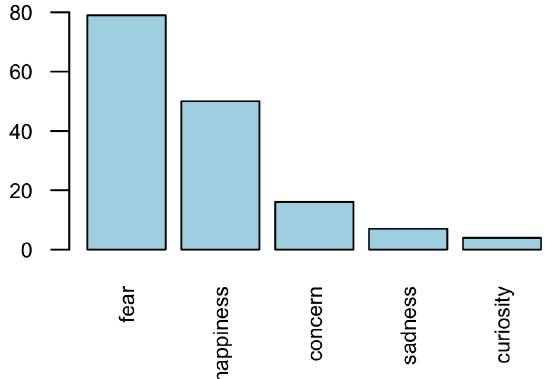
Figure 4. Frequencies of terms related to sentiments like fear, hap- piness, concern, sadness, and curiosity. The corresponding Italian terms are as follows: fear – paura (fear), panico (panic), impaurito (frightened), spaventato (scared), and spaventare (to scare); hap- piness – felice (happy), contento (glad), and gioia (joy); concern – preoccupato (worried) and preoccupazione (concern); sadness – tristezza; curiosity – curioso (curious) and incuriosito (intrigued). Both singular and plural and masculine and feminine terms are al- ways counted. In the case of verbs, different tenses and persons are